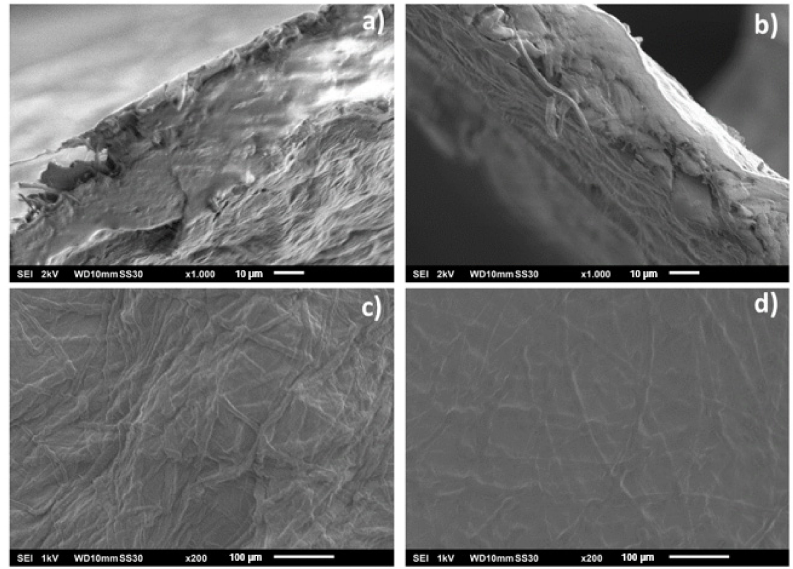
Figure 4. Scanning electron microscopy images of enzymatic CNF films prepared by solvent casting